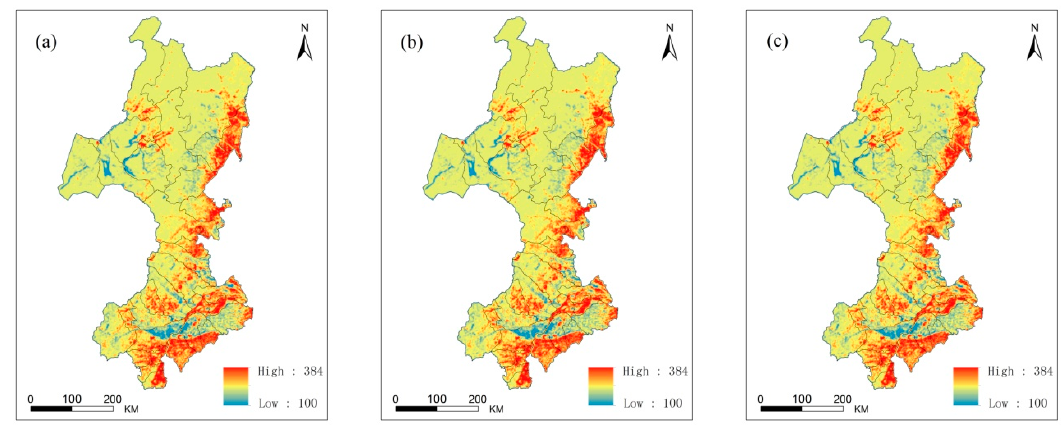
Figure 7. Land use degree in the study area: ( a ) land use degree in 2000; ( b ) land use degree in 2005; ( c ) land use degree in 2010. Table 7. Land use degree per unit area in administrative region.